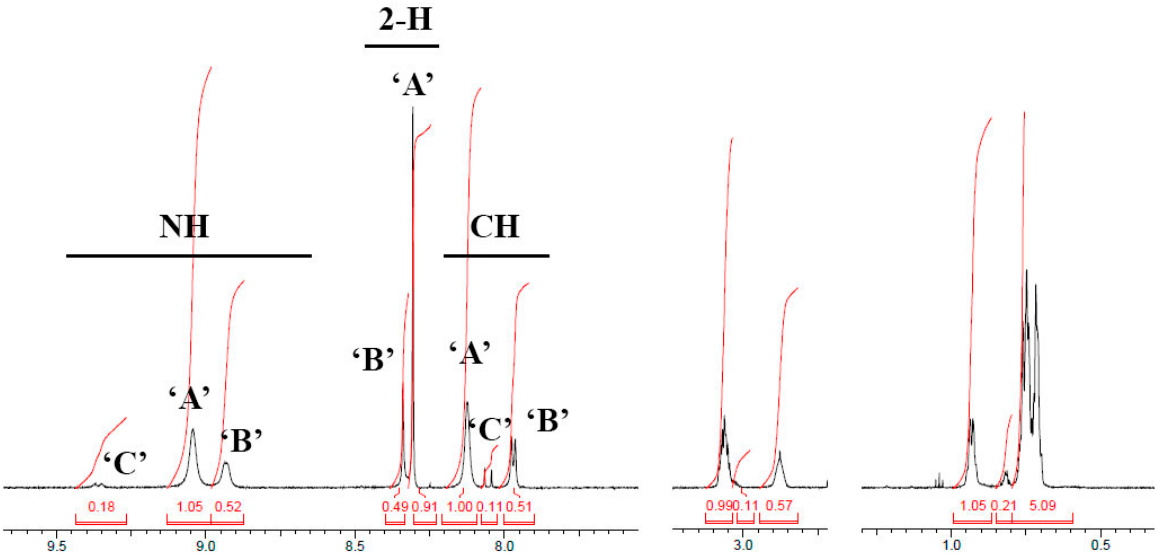
Figure 3. 1 H-NMR spectrum of 5c . Signals of A, B, C forms of 5c are shown.